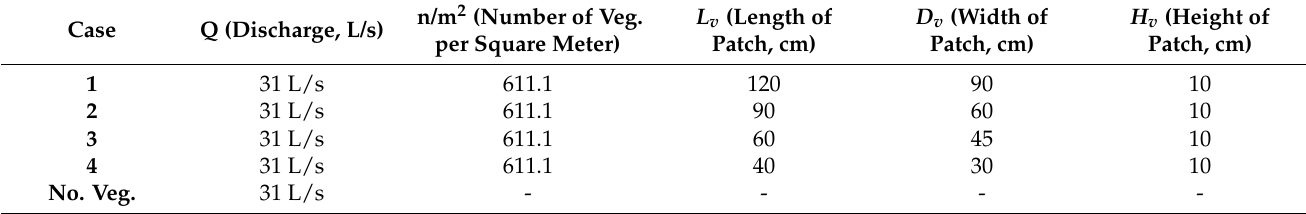
Figure 1. ( A ) The layout of the experimental device, ( B ) a sample of vegetation patches (120 × 90 cm, D V /D C = 1), ( C ) sample of vegetation patch in a natural gravel bed river (Marbor River, Iran), ( D ) a sample of bed materials, ( E ) a single synthetic plant used to simulate patch; ( F ) a sketch of the experimental setup (not to scale). Table 1. Experimental parameters for the cases discussed in this